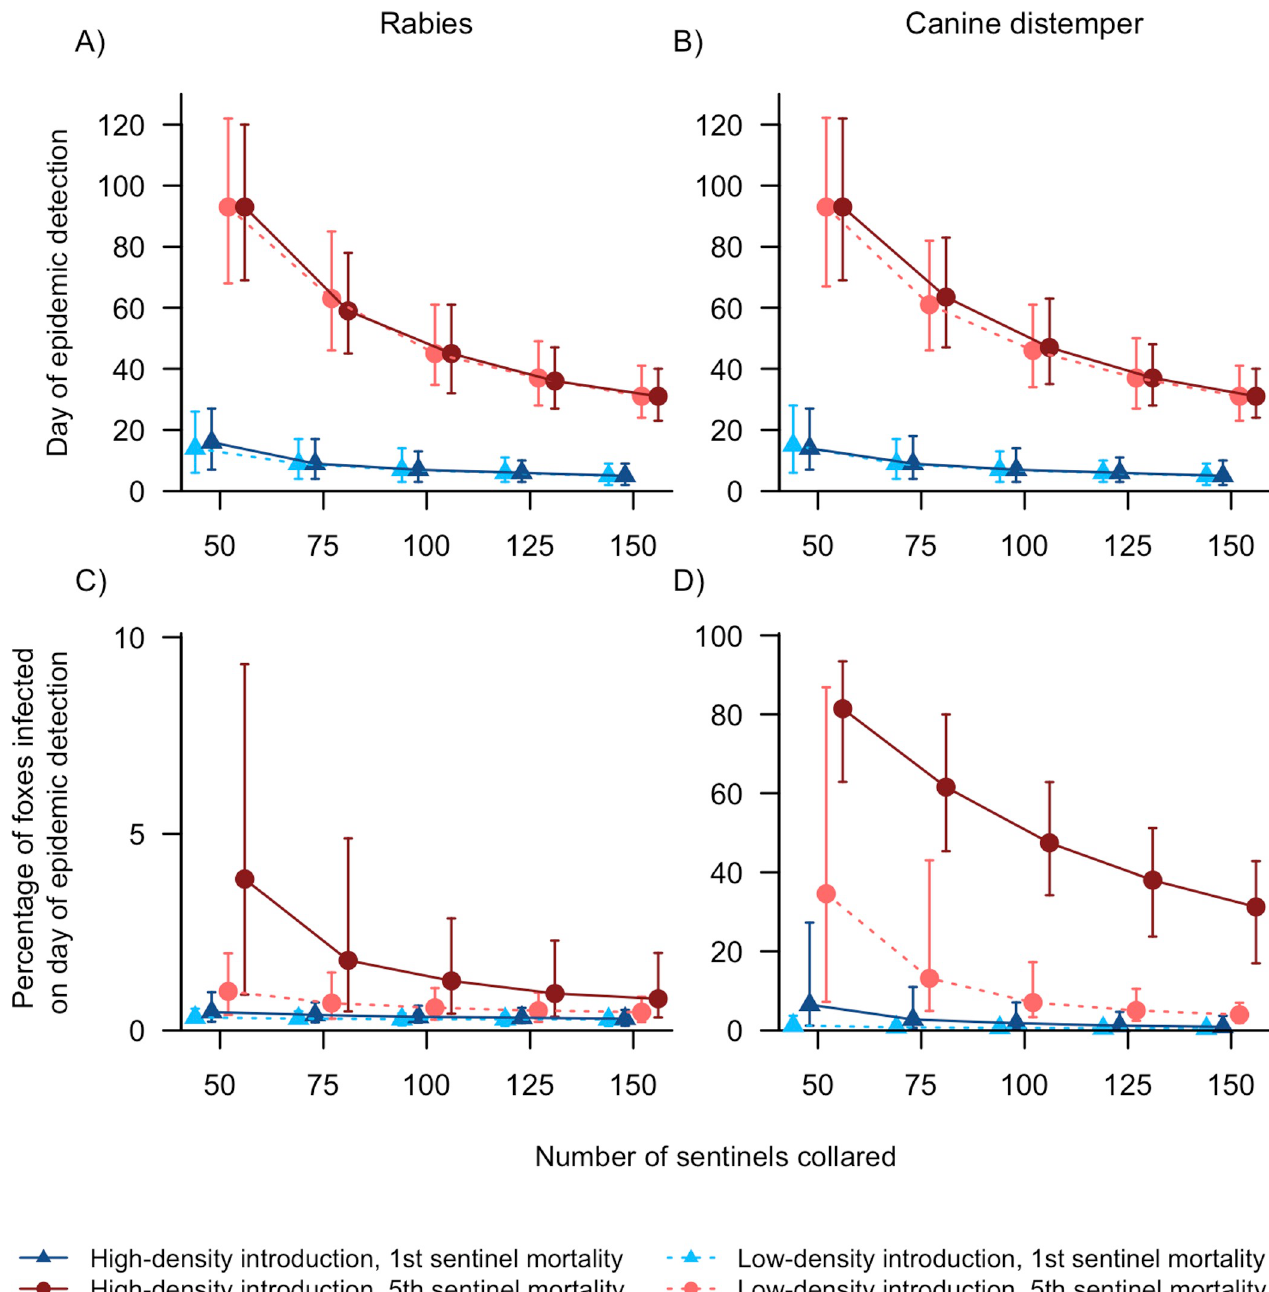
Fig 3. Model simulation results (medians, 25% and 75% quartiles) of rabies (A, C) and canine distemper (B, D) introduction to areas of San Clemente Island with low or high fox density and no vaccination, with varying numbers of radio-collared sentinels. As the number of unvaccinated sentinel foxes increased, the number of days until epidemic detection (A, B) and the percentage of foxes infected (i.e. latent, infectious, or dead) by the day of detection (C, D) decreased. Note the different y-axis of panel C. The variability in time to epidemic detection among model iterations (error bars in Fig 3A and 3B) was influenced by monitoring frequency and intensity. When only 50 sentinels were